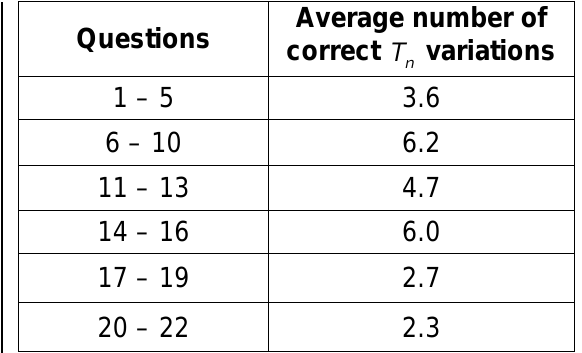
Table 4. Average number of per question